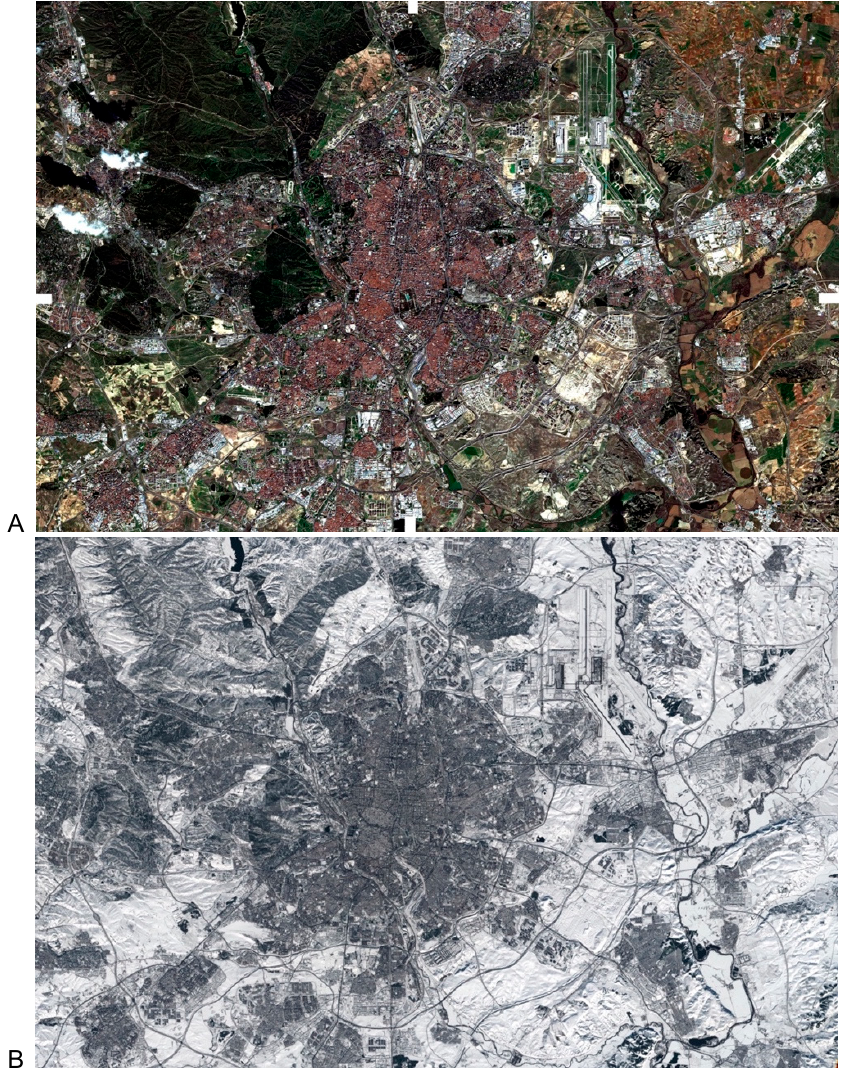
Figure 3. Sentinel 2B MSI views of Madrid city. ( A ): 13:07Z, January 3rd; ( B ): 13:24Z January 11th. Both images are the ‘true color’, 4/3/2 bands combinations. White indents in the margins in the top image pinpoint the pond at Retiro Park. Raw data from the Copernicus service; processing and graphics done at UCLM.